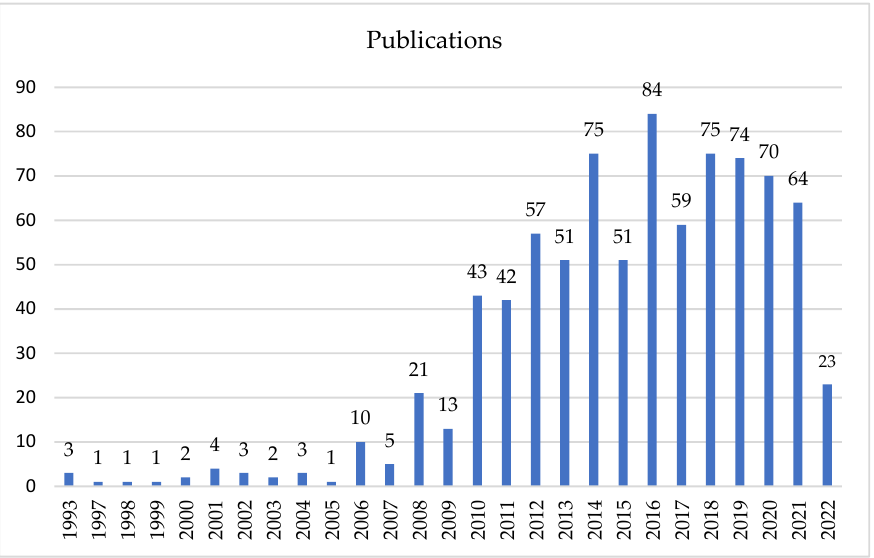
Figure 1. Annual publications related to search string.